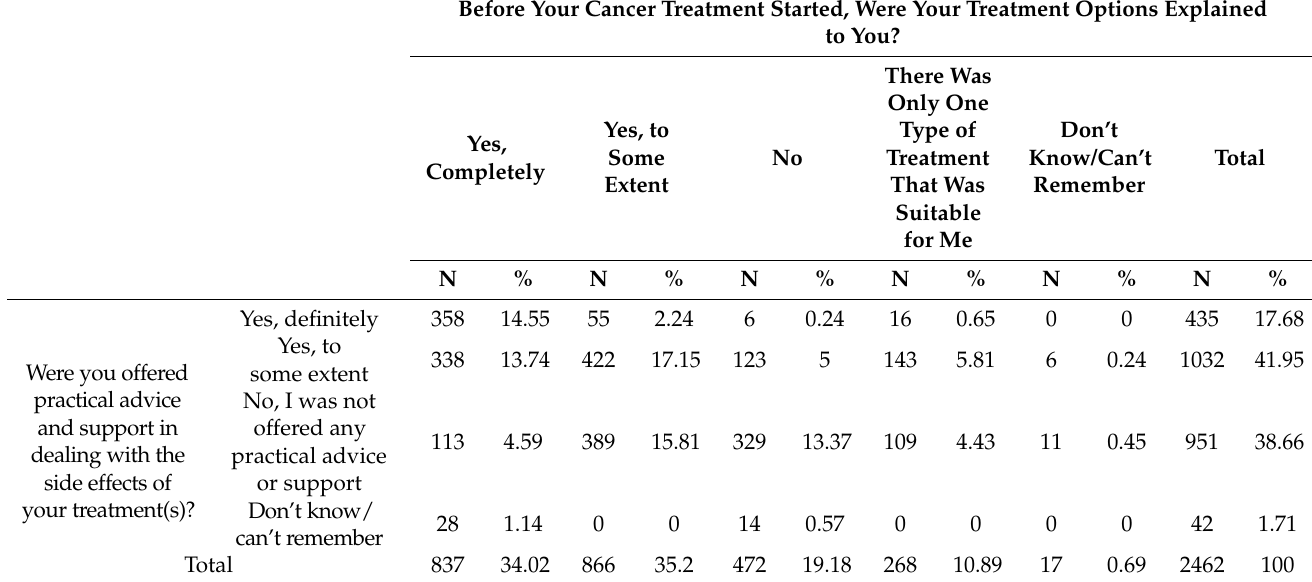
Table 3. Cross tabulation of the offered treatment options, advice, and support in dealing with side effects of treatment(s).